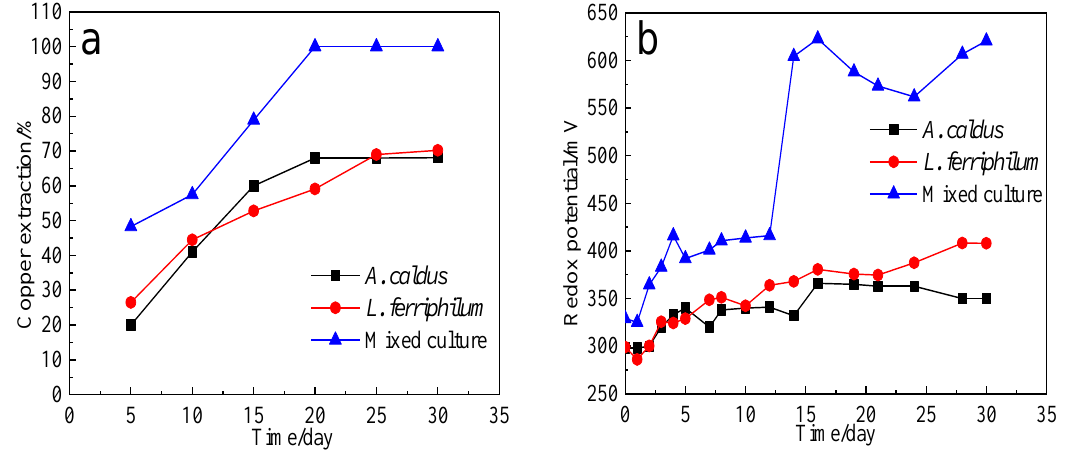
Figure 17. Bioleaching of bornite by A. caldus , L. ferriphilum and mixed culture consisting of A. caldus and L. ferriphilum : ( a ) Copper extraction; ( b ) Redox potential.